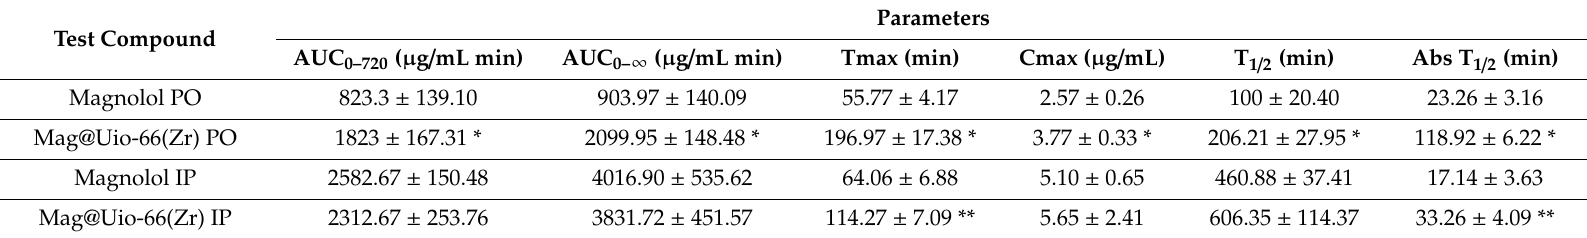
Table 1. Summary of the pharmacokinetic parameters for oral and intraperitoneal route of magnolol and